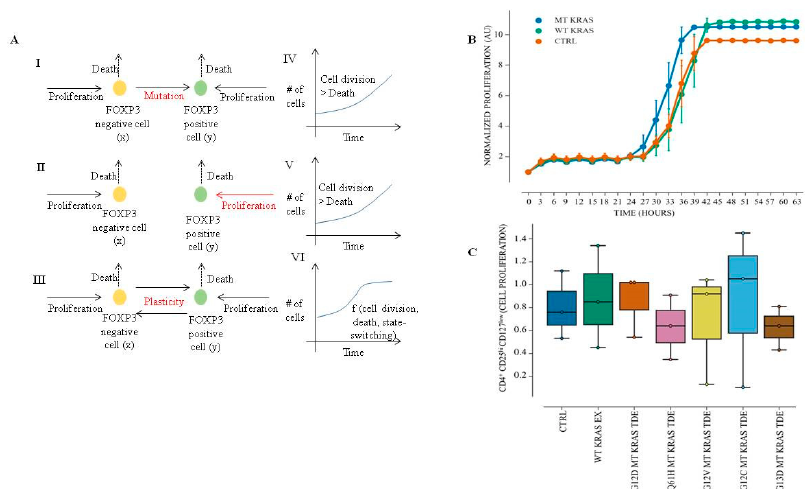
Figure 2. Mathematical modeling of phenotypic switching of T cells to Treg-like cells. ( A ) I–III Figure2. MathematicalmodelingofphenotypicswitchingofTcellstoTreg-likecells. ( A )I–IIIschematics schematics representing various scenarios that have been mathematically modeled. IV–VI representing various scenarios that have been mathematically modeled. IV–VI representative outcomes representative outcomes of three scenarios (respectively presented in the same row) showing that the of three scenarios (respectively presented in the same row) showing that the cell population continues cell population continues to grow in IV–V, but tends to reach a steady state in VI. ( B ) Naïve CD4 + to grow in IV–V, but tends to reach a steady state in VI. ( B ) Naïve CD4 + CD25 − T cells were incubated CD25 − T cells were incubated with MT or WT KRAS TDEs for 24 h. Cell proliferation was analyzed with MT or WT KRAS TDEs for 24 h. Cell proliferation was analyzed using the IncuCyte Live Cell using the IncuCyte Live Cell Imaging System. Graph shows the mean and standard deviation of Imaging System. Graph shows the mean and standard deviation of duplicate wells. ( C ) CD4 + CD127 low duplicate wells. ( C ) CD4 + CD127 low CD25 + cells isolated from healthy donor PBMCs were incubated CD25 + cells isolated from healthy donor PBMCs were incubated for 24 h with WT or Q61H MT KRAS for 24 h with WT or Q61H MT KRAS TDEs isolated from the serum of NSCLC cancer patients, and TDEs isolated from the serum of NSCLC cancer patients, and cell proliferation was assessed using cell proliferation was assessed using the IncuCyte Live Cell Imaging System. Box plots represent the the IncuCyte Live Cell Imaging System. Box plots represent the interquartile range (IQR), with the interquartile range (IQR), with the horizontal line indicating the median. Whiskers extend to the horizontal line indicating the median. Whiskers extend to the farthest data point within a maximum of farthest data point within a maximum of 1.5 × IQR. All p-values were calculated using the Mann– 1.5 × IQR. All p-values were calculated using the Mann–Whitney U Whitney U -test.